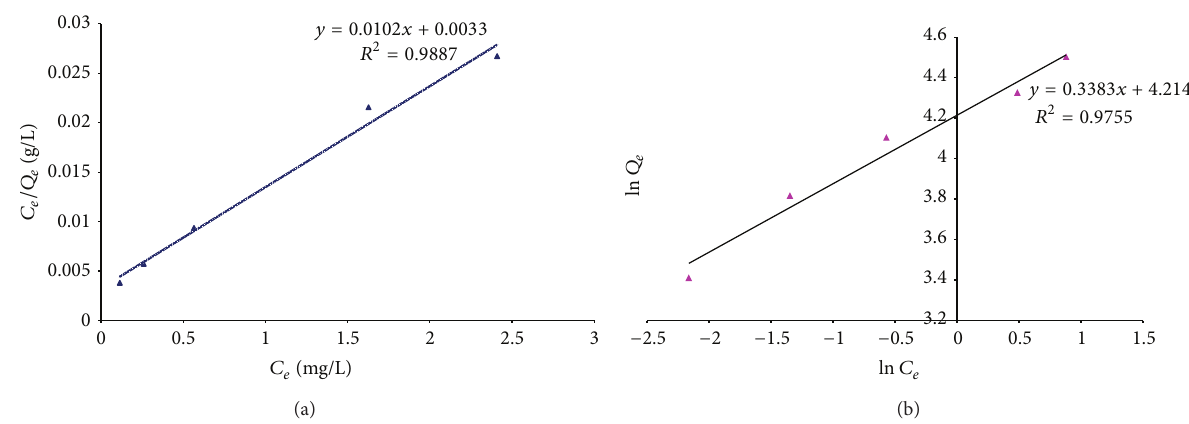
Figure 5: The linear plots, (a) from Langmuir adsorption model and (b) from Freundlich adsorption